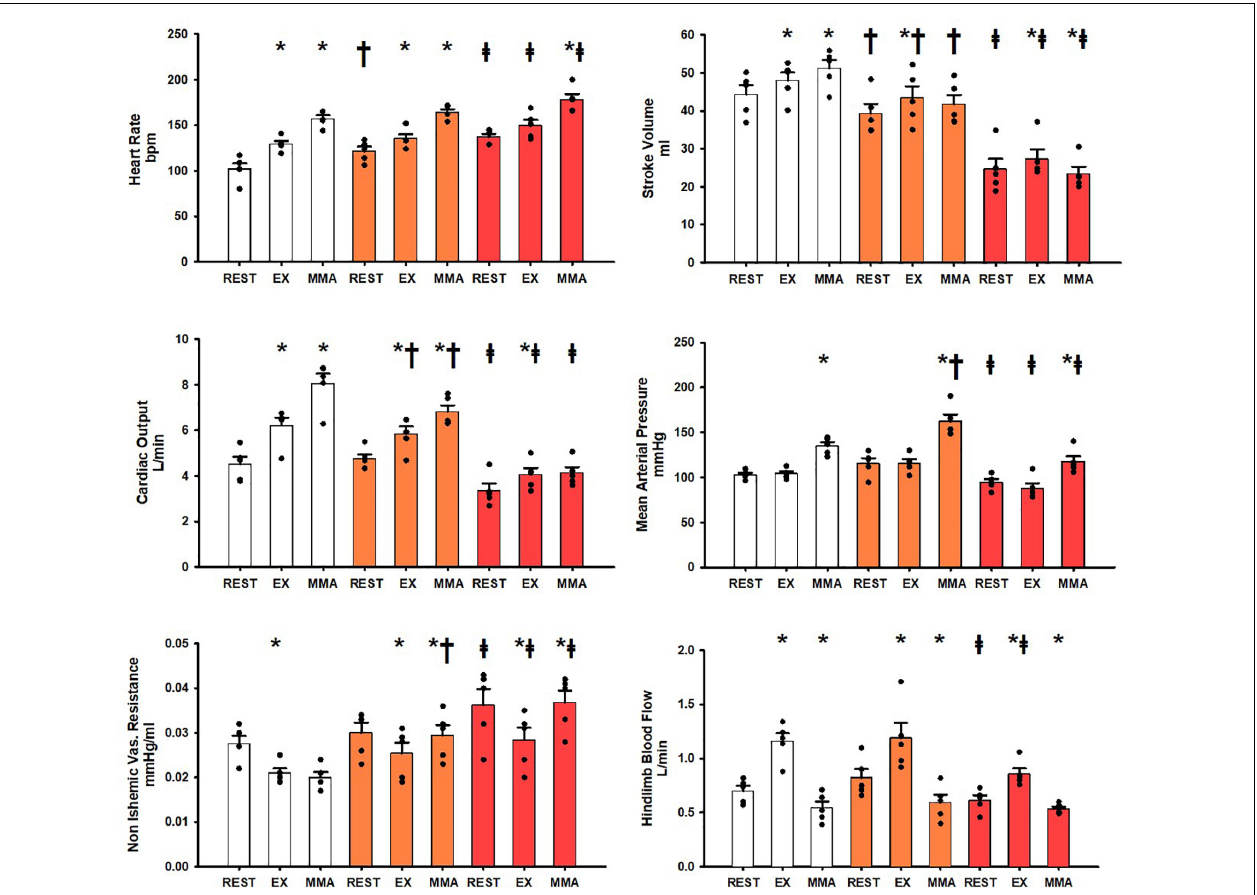
FIGURE 2 | Average 1-min steady state hemodynamics from the SAD group at rest, exercise (EX), and exercise with muscle metaboreflex activation (MMA) before (white) an after SAD (orange) and after induction of heart failure post SAD (red). Data are reported as means with standard error. Observed data points are overlain on corresponding bar graphs. Statistical significance vs. previous workload depicted as * where P < 0.05. Comparisons of the condition of SAD vs. control depicted as † where P < 0.05. Comparisons of the condition of heart failure vs. SAD depicted as ‡ where P < 0.05. ( N =